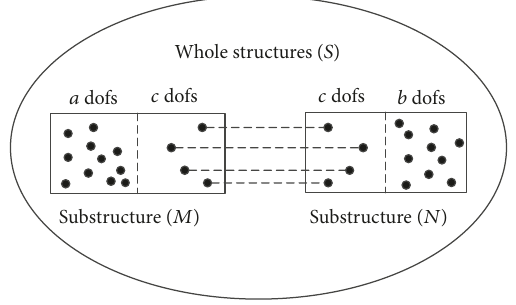
Figure 1: Schematic of